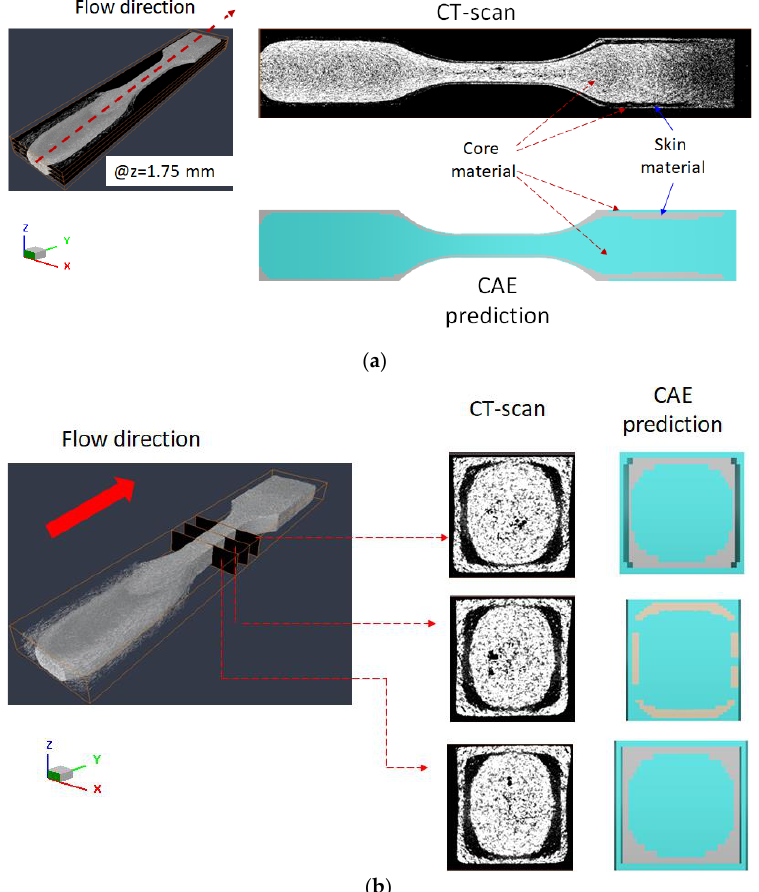
Figure 13. The CAE prediction and experimental examination by micro-CT scan and image analy- sis on the “core-skin-core” structure for the PP/30SFPP system at the skin to core ratio of 30/70 through cross-section observation. ( a ) XY-plane at central thickness and ( b ) XZ-plane at central region along flow direction.